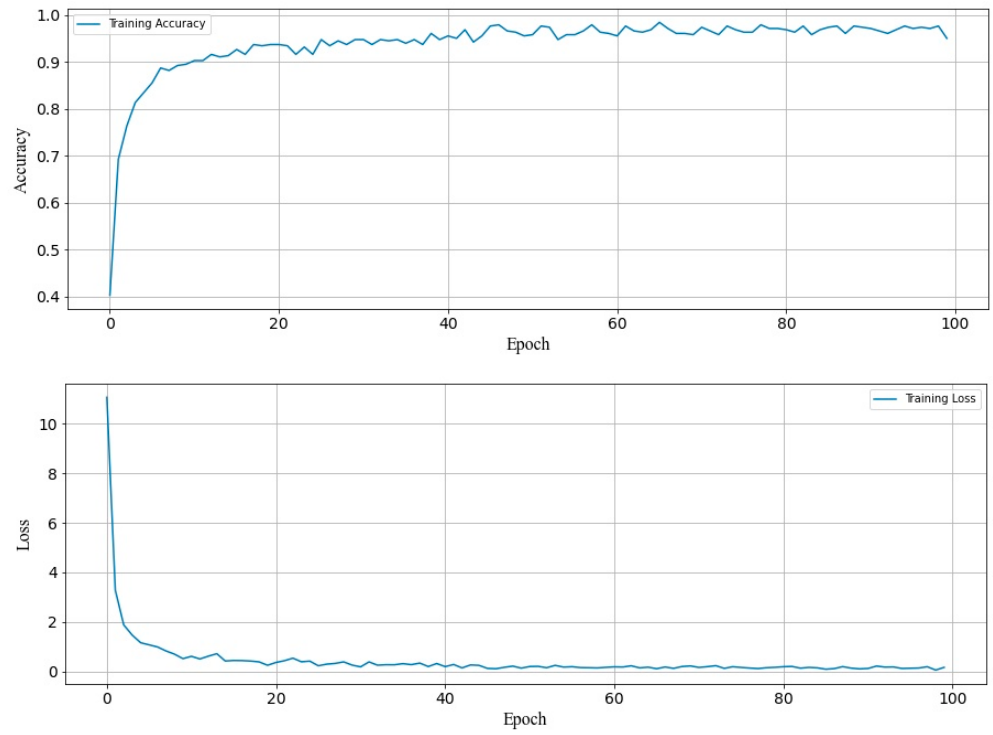
Figure 14. Accuracy and loss after training 100 times.